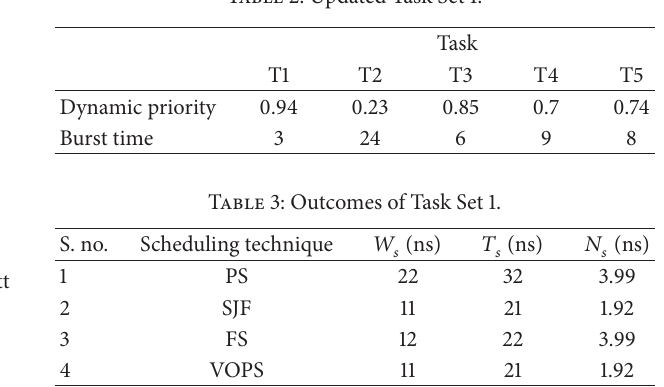
Table 2: Updated Task Set 1.